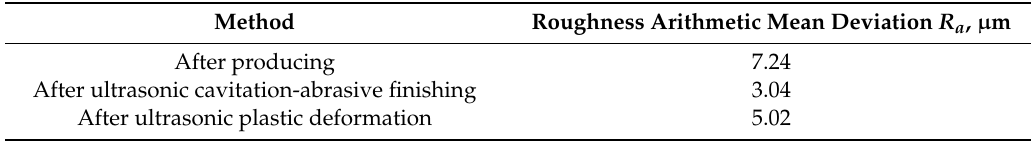
Table 4. The 20Kh13 (DIN 1.4021) steel surface average roughness after various type of